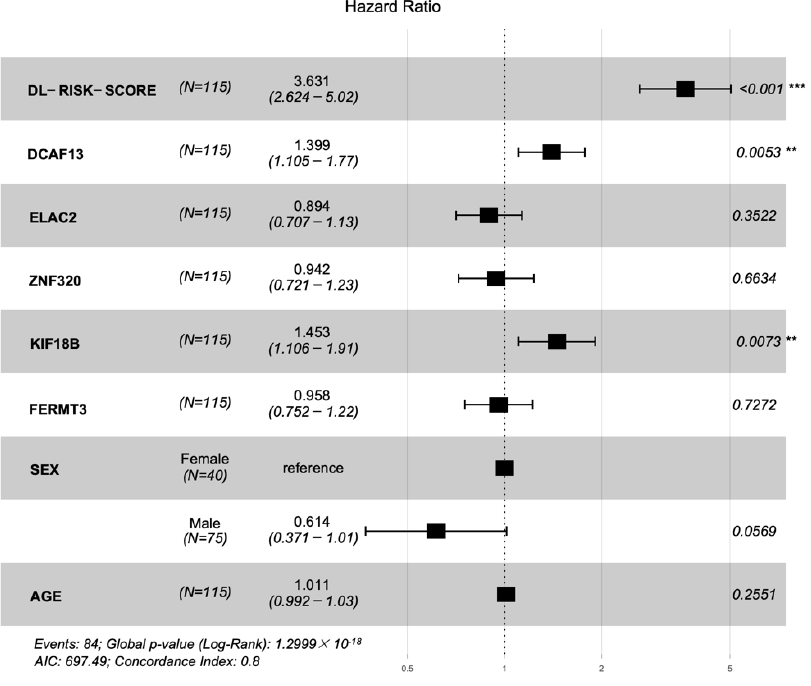
Figure 7. Forest plot of the hazard ratios with 95% confidence intervals (CIs) and p -values obtained from the multi − modality model including the deep learning risk score, hub genes, and clinical characteristics of the cohort. The ‘***’ indicated p -value < 0.001, and the ‘**’ indicated p -value < 0.01.